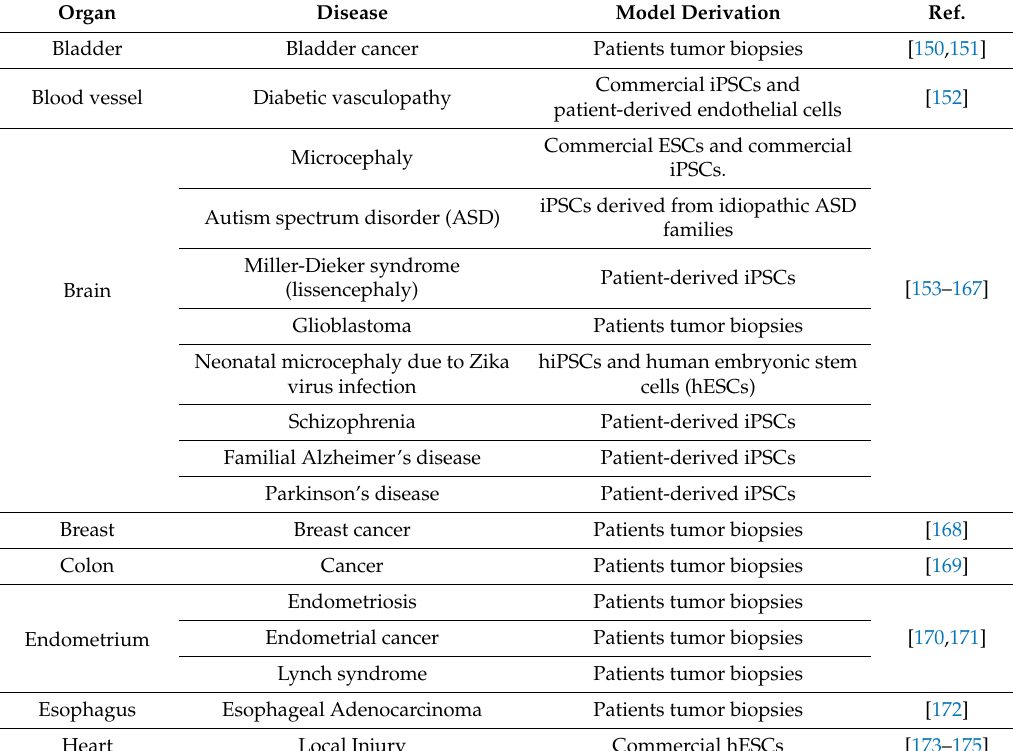
Table 5. List of human organoids disease